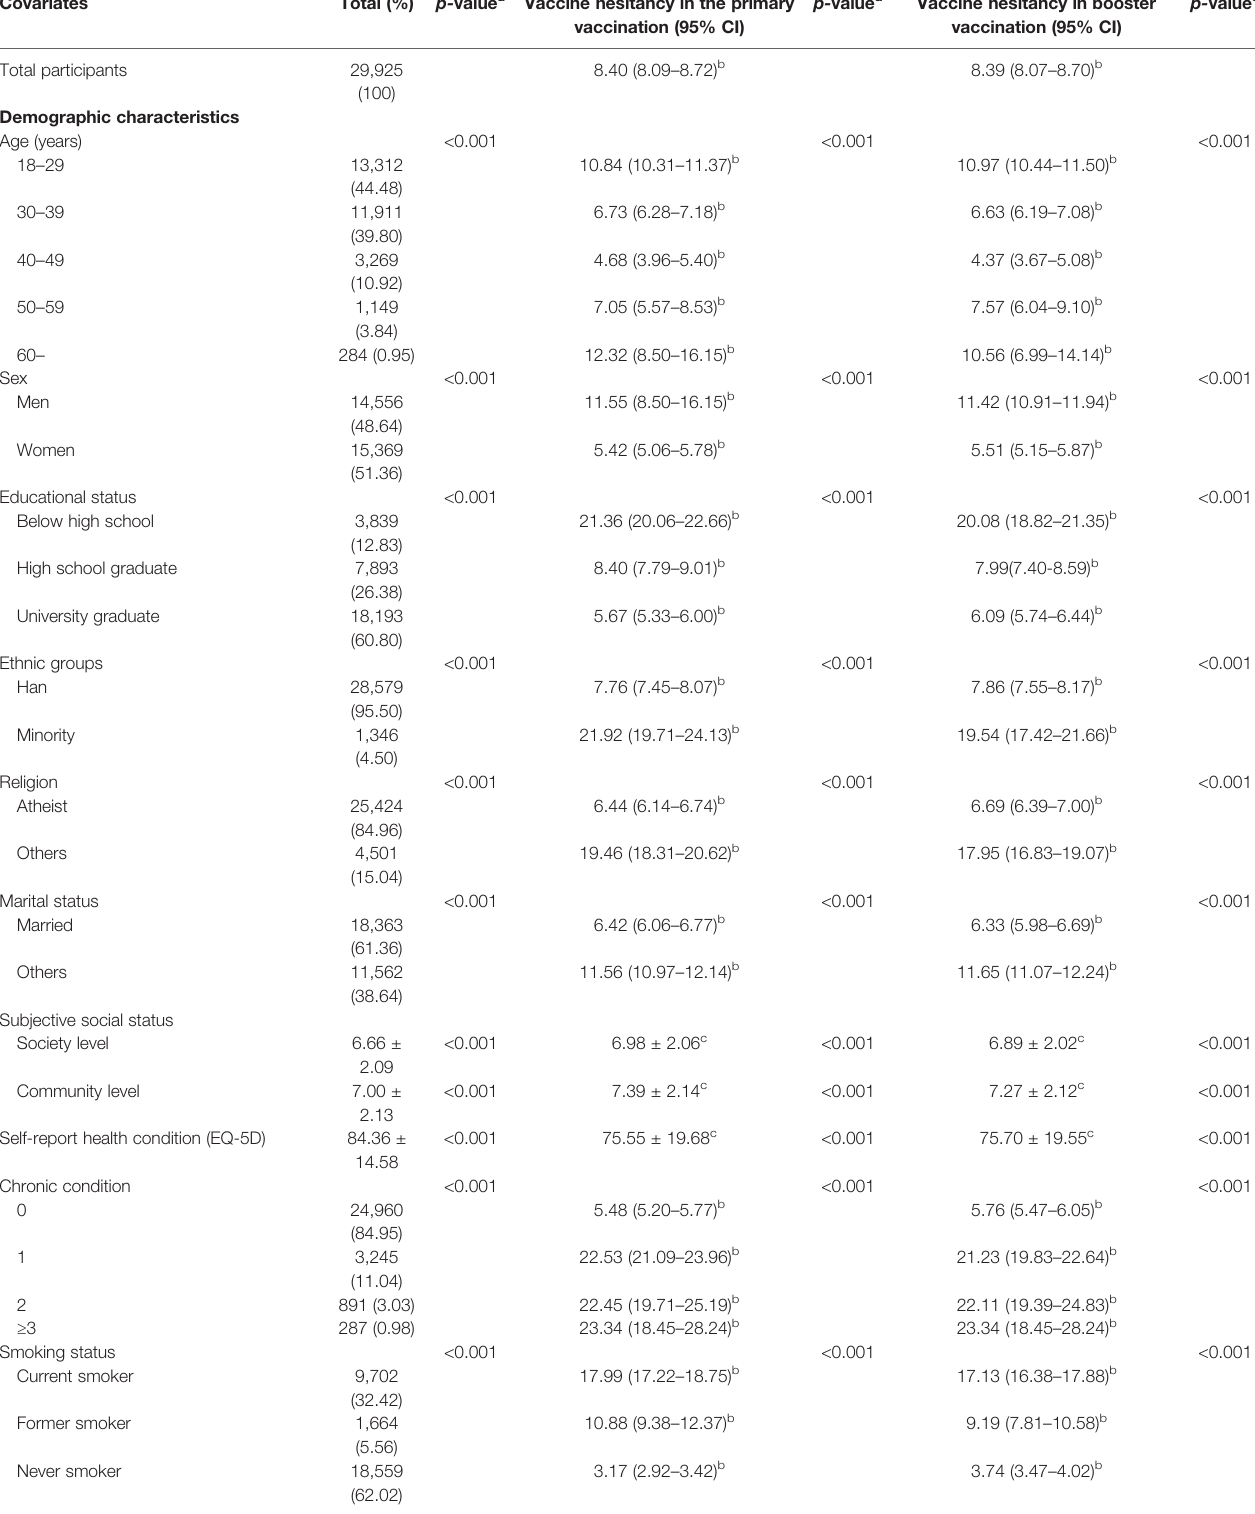
TABLE 1 | Sociodemographic, awareness of COVID-19 pandemic, COVID-19 vaccine exception, trust in healthcare system, and COVID-19 vaccine hesitancy of all study participants.